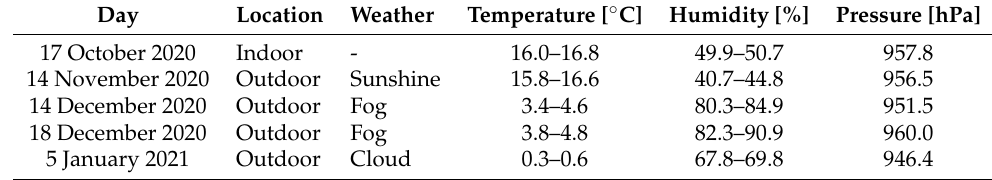
Table 3. Weather conditions at the dynamic experiments carried out between October 2020 and January